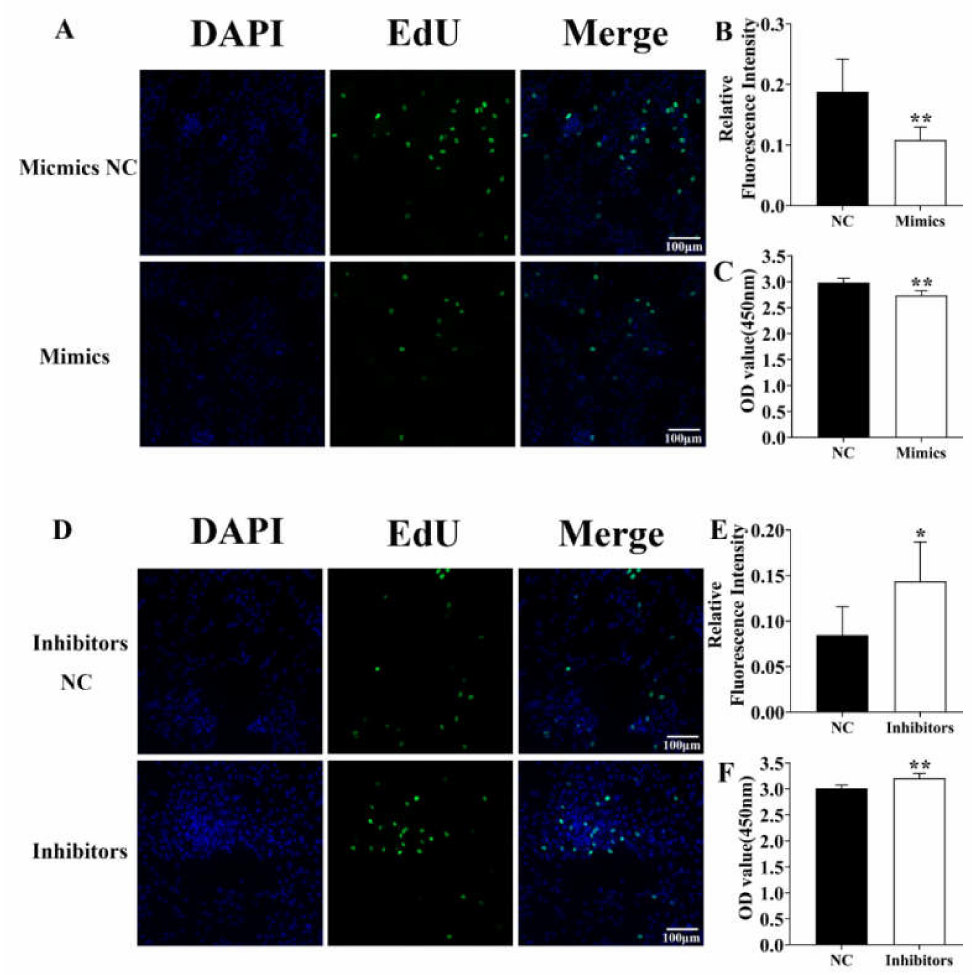
Figure 4. Ssc-miR-124 inhibited pre-adipocyte proliferation. ( A , D ) Detection of pre-adipocyte positive EdU level after transfecting ssc-miR-124 mimics ( A ) or ssc-miR-124 inhibitors ( D ) for 48 h. The proliferating nuclei were stained green with EdU (50 µ M) for 4 h, while the nuclei of all cells were stained blue with Hoechst33342 for 30 min. The scale bar was 100 µ m. ( B , E ) Quantification of the relative fluorescence intensity of EdU-positive cells (EdU/DAPI) by ImageJ software. ( C , F ) The Cell Counting Kit-8 assay (CCK-8) detection after transfecting ssc-miR-124 mimics ( A ) or ssc-miR-124 inhibitors ( D ) for 48 h (n = 9 per group). The wavelength of CCK-8 detection was 450 nm. Data are presented as mean ± s.e.m. * means P < 0.05, ** means P < 0.01. The above results further proved that ssc-miR-124 suppressed porcine C/EBP α and GR by targeting their 3 (cid:48) UTR, and thus inhibiting their protein